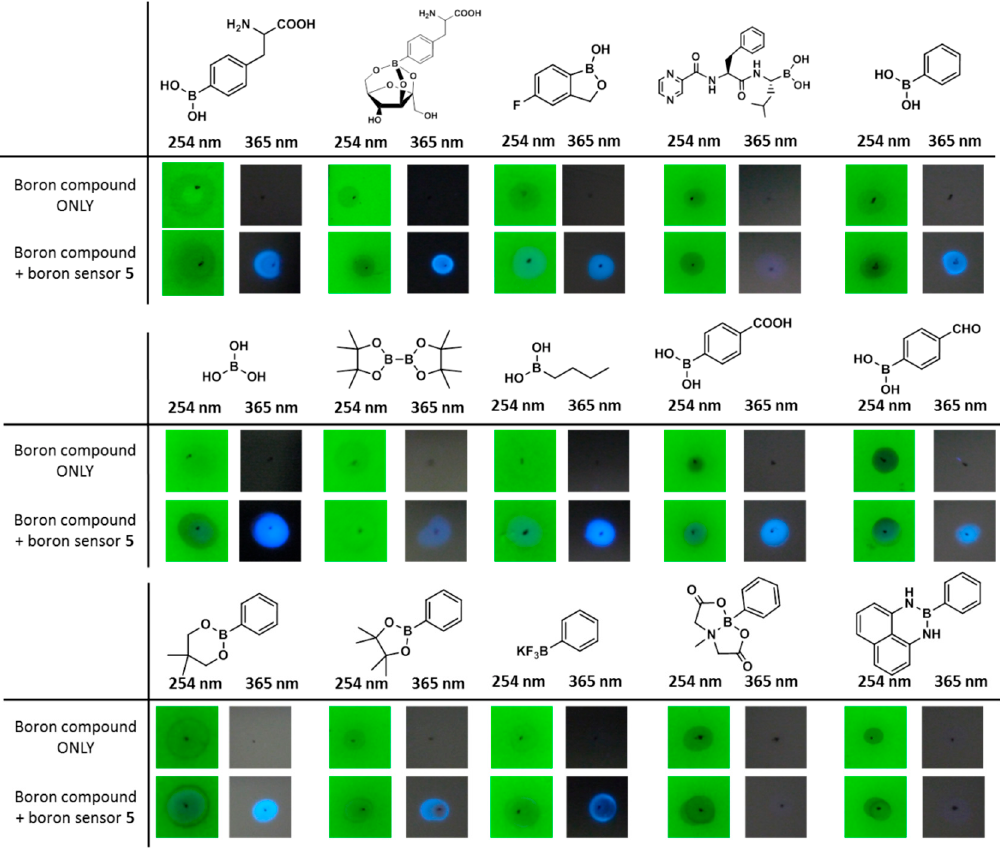
Figure 5. Staining test of various boron-containing compounds spotted onto silica-gel plates followed by the addition of boron sensor 5 ( viewed by illumination at 254 or 365 nm using a handheld UV lamp).